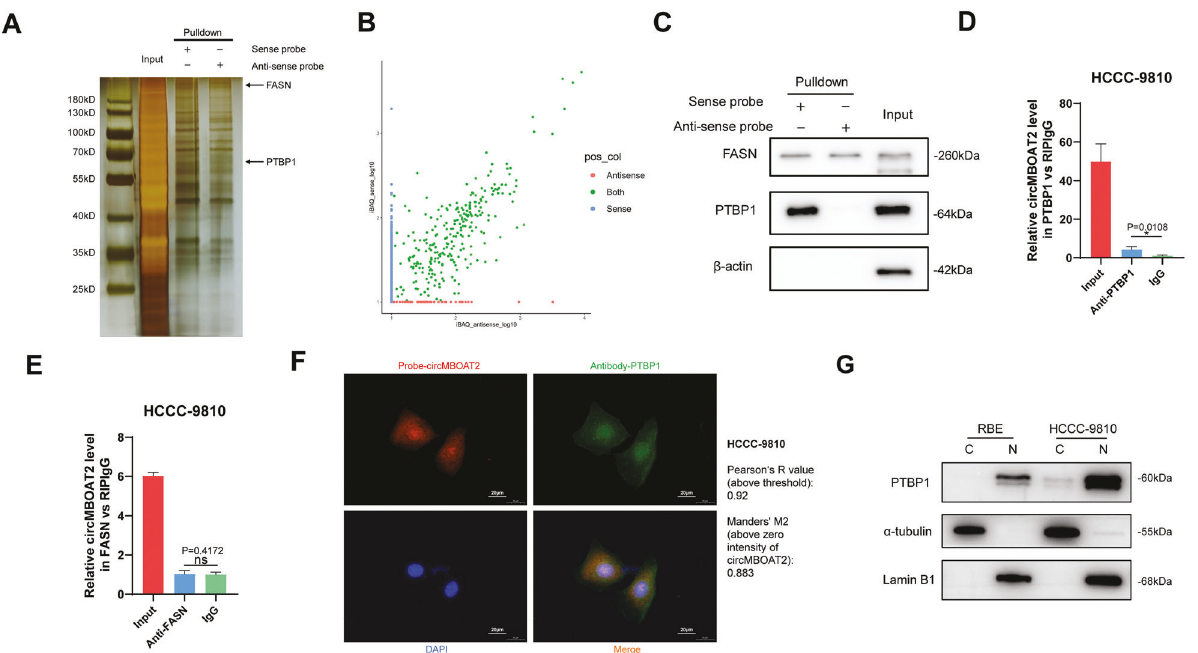
Fig. 4 CircMBOAT2 interacts with PTBP1 in ICC cells. A RNA pull-down assay was performed; SDS-polyacrylamide gel electrophoresis (SDS/ PAGE) and silver staining were used to detect RNA-related proteins. B Label-free intensity-based absolute quanti fi cation (iBAQ) method to quantify conjugated protein abundance with sense probe and anti-sense probe. C Western blot analysis was performed to detect the speci fi c association of circMBOAT2 and PTBP1/FASN. β -actin was used as a negative control. D, E RNA immunoprecipitation (RIP) assay. CircMBOAT2 was precipitated by an anti-PTBP1 antibody speci fi cally but an anti-FASN antibody nonspeci fi cally was then detected by qRT-PCR in HCCC- 9810 cells. IgG was used as a negative control. Signi fi cant differences between groups were analyzed by unpaired t-test. Error bars represent the means ± SEM of three independent experiments. F Immuno fl uorescence detected the co-localization of PTBP1 (green) with circMBOAT2 (red) in HCCC-9810 cells. G Subcellular localization of PTBP1. N nucleus, C cytoplasma. Scale bar = 20 μ m. Analysis of colocalization was performed by